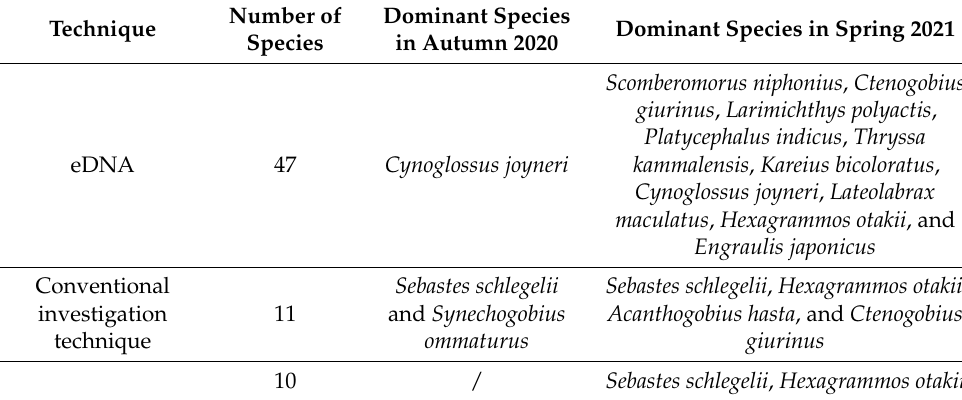
Table 7. Comparison of eDNA and conventional investigation